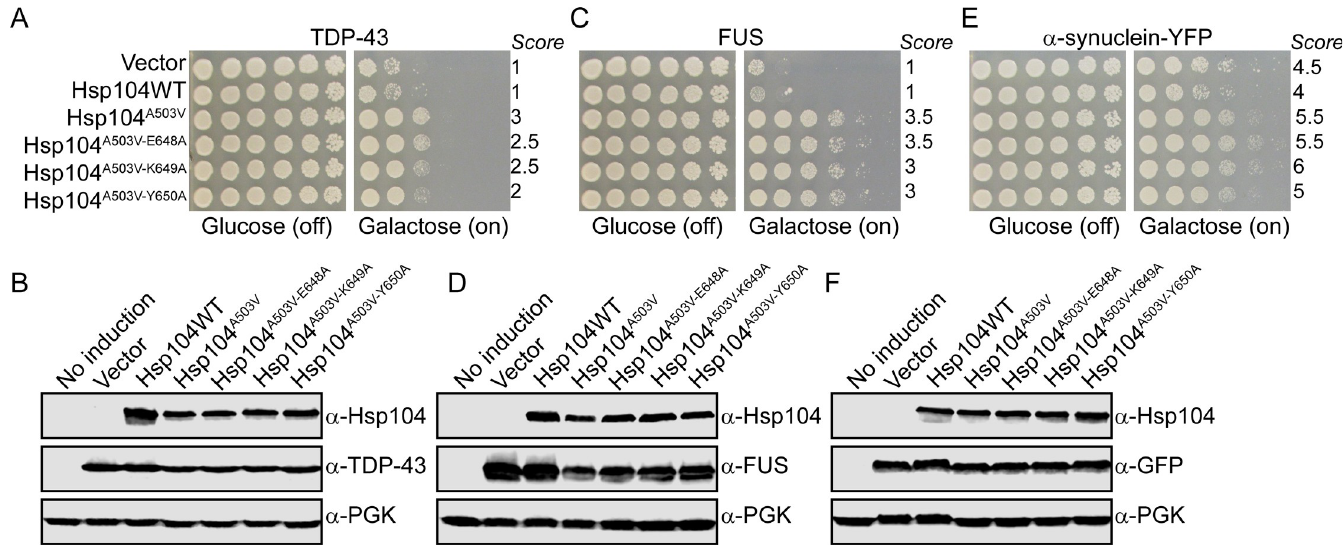
Fig 5. Ablation of residues adjacent to Hsp104 Y650 do not diminish rescue of potentiated Hsp104 A503V . (A) W303 Δ hsp104 yeast integrated with the gene encoding TDP-43 were transformed with the indicated 416GAL-Hsp104 plasmid or empty vector control. Strains were serially diluted 5-fold and spotted on glucose (off) or galactose (on) media. Scores are based on number of spots (from 1 to 6), based on an average of three biological replicates. (B) Strains from A were induced for 5h, lysed, and immunoblotted. 3-Phosphoglycerate kinase (PGK) serves as a loading control. (C-D) Experiments were carried out as in A, except with a strain integrated with the gene encoding FUS. (E-F) Experiments were carried out as in A, except with a strain doubly integrated with the gene encoding α -synuclein-YFP.